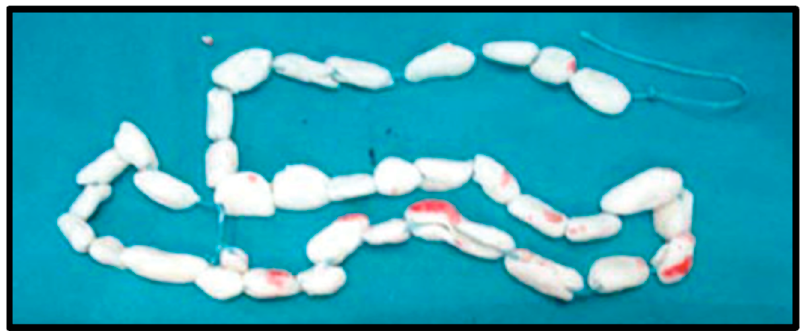
Figure 1. PMMA beads can be created by a hand over suture or wire, with or without the use of prefabricated templates. Beads provide no structural integrity but effectively occupy dead space and provide a higher level of antibiotic elution due to greater surface area than mono-block creations.